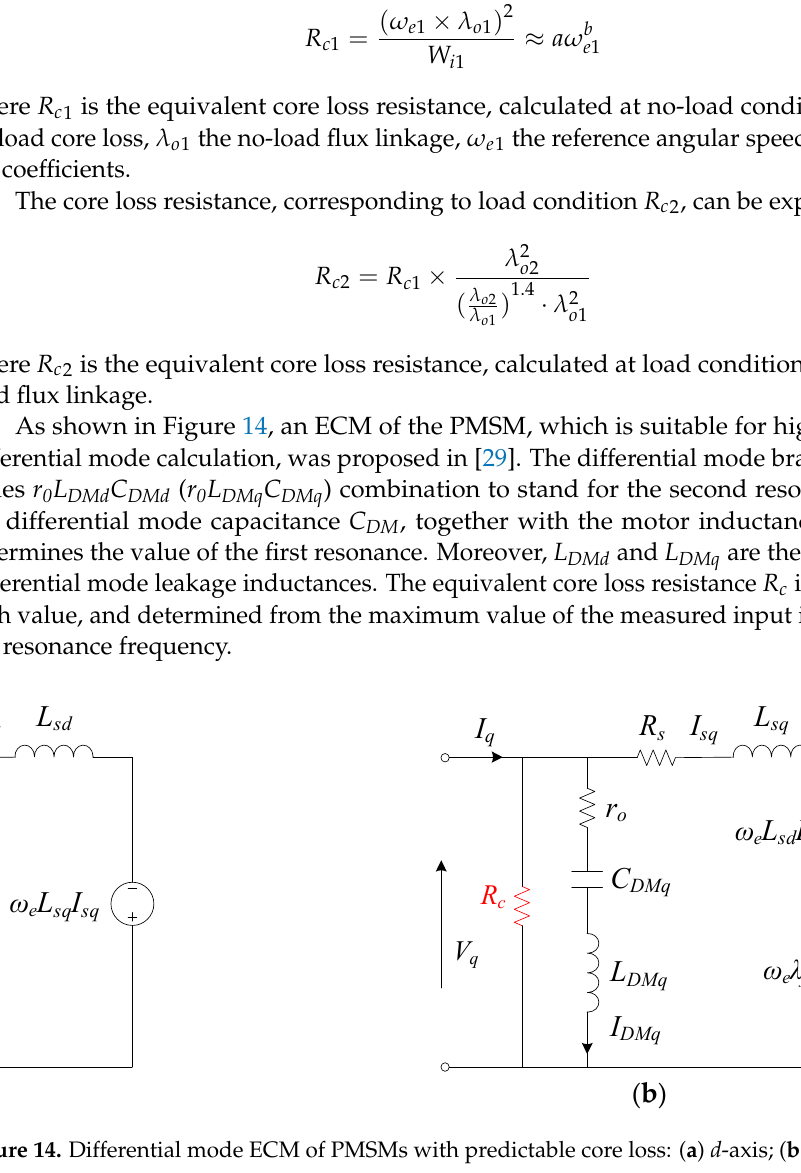
Figure 15. ECM of PMSMs with predictable core loss and PM loss: ( a ) d -axis; ( b ) q -axis [30]. Based on the ECM of Figure 15, the copper loss and the sum of the core loss and PM loss can be described as [30]: